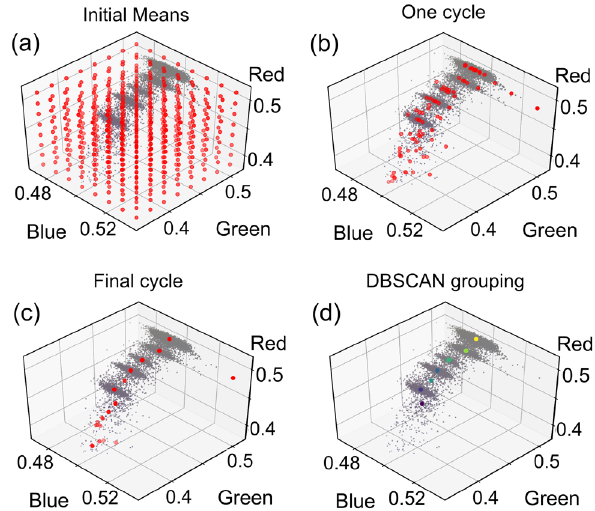
Figure 2. Mean shift and DBSCAN clustering for identification of cluster centers. ( a ) The same data as in Fig. 1d with red closed circles showing the initial positions of the mean points in the mean shift algorithm. ( b ) Scatter plot after one cycle of mean shift; outlier mean points have been deleted and others have moved towards their local density maxima. ( c ) The final state of the mean points after they have converged to their maxima. ( d ) The RGB pixels plotted with the identified cluster centers (colored closed circles) after the DBSCAN